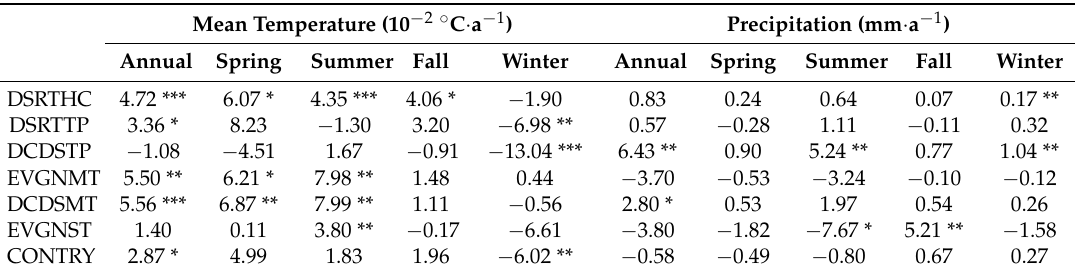
Table 3. Temporal trends in annual and seasonal climate based on the Generalized Least Squares Regression. p values were based on one-tailed hypothesis, and “*”, “**”, and “***” are for p -values less than 0.1, 0.05, and 0.01,